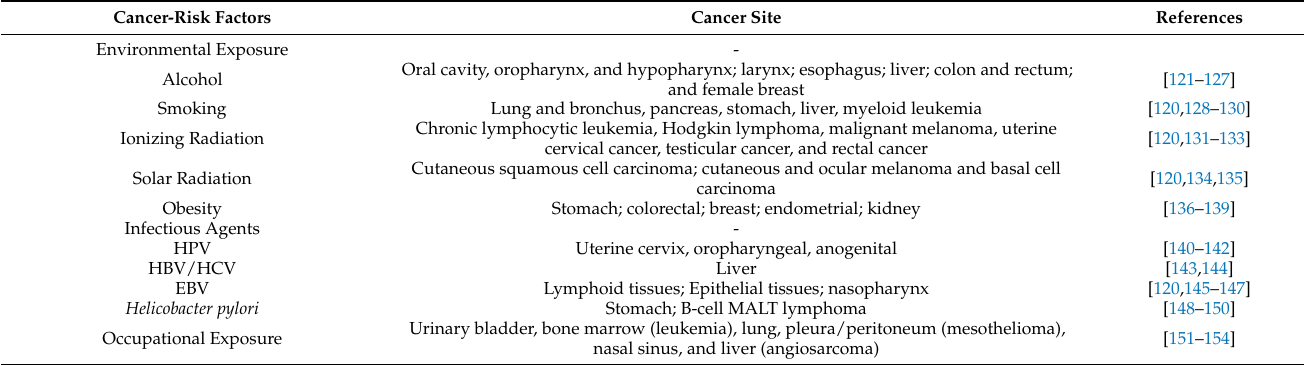
Table 1. Risk factors of environmental exposure, lifestyle